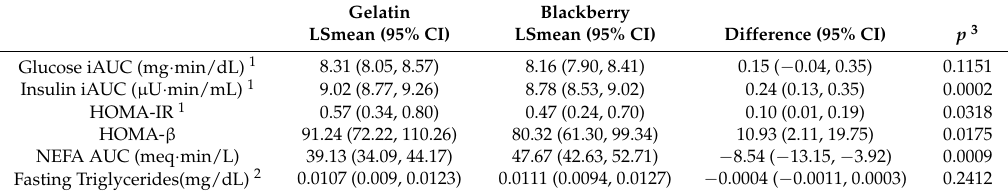
Figure 3. Blood glucose ( A ) and insulin ( B ) concentrations as a function of time after administration of the meal-based glucose tolerance test including either blackberries or gelatin. Asterisks indicate significant differences between the gelatin and blackberry diet treatments, p < 0.05. Time-response curves are arithmetic means ± SE. n = 24 subjects. Table 5. Biochemical measures in blood after consumption of blackberries or gelatin for seven days.